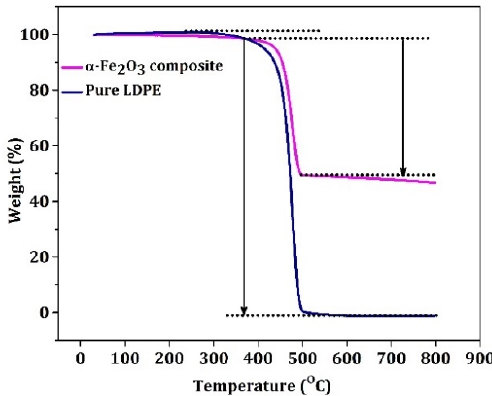
Figure 4. TGA of pure LDPE and LDPE/GNP/MWCNT/ α‐ Fe 2 O 3 polymer nanocomposite.